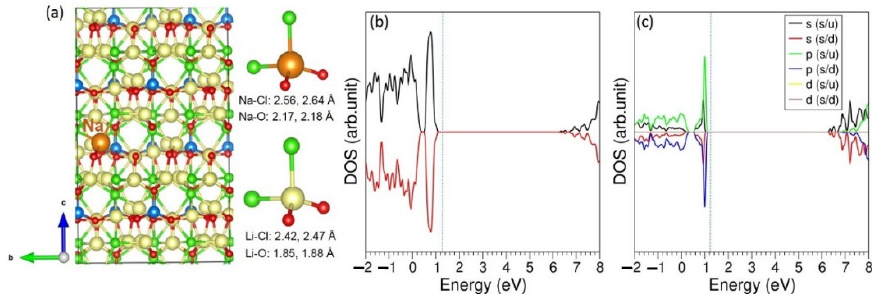
Figure 3. ( a ) Optimized structure of Na-doped Li 6 SiO 4 Cl 2 , ( b ) its total DOS plot, and ( c ) atomic DOS plot of Na.